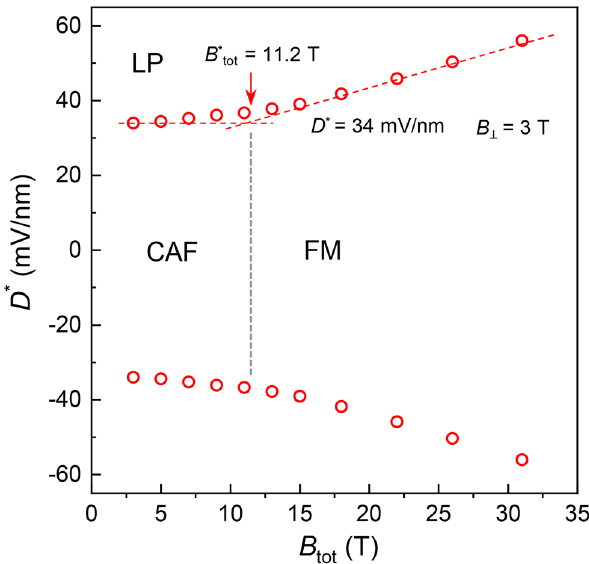
FIG. 15. The phase diagram of ν ¼ 0 in bilayer graphene at B ⊥ ¼ 3 T showing the CAF-LP transition at 34 mV = nm and the ¼ 11 . 2 T. Adapted from Ref. CAF-FM crossover at B tot